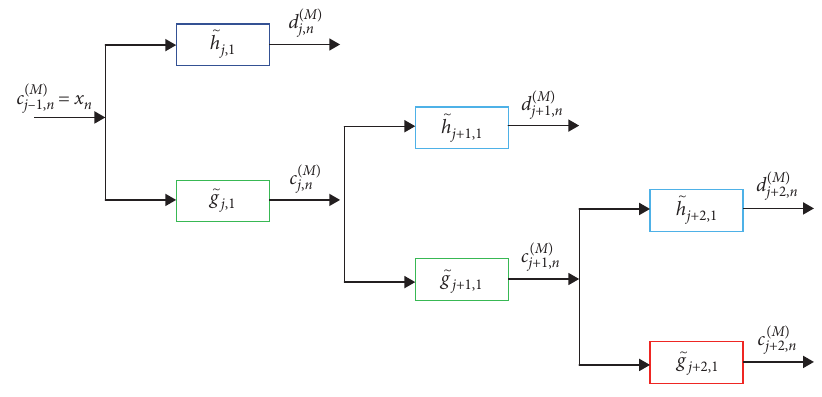
Figure 1: Wavelet separation of